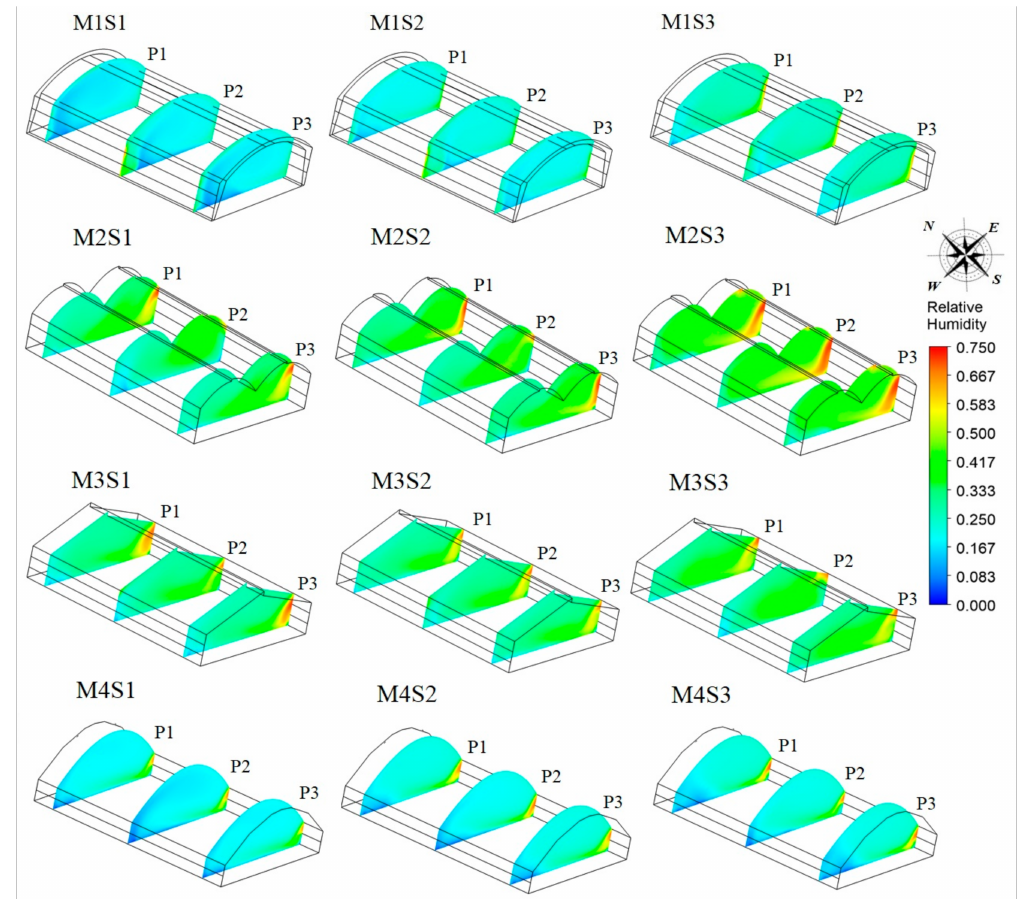
Figure 7. Spatial distribution of relative humidity for all simulated